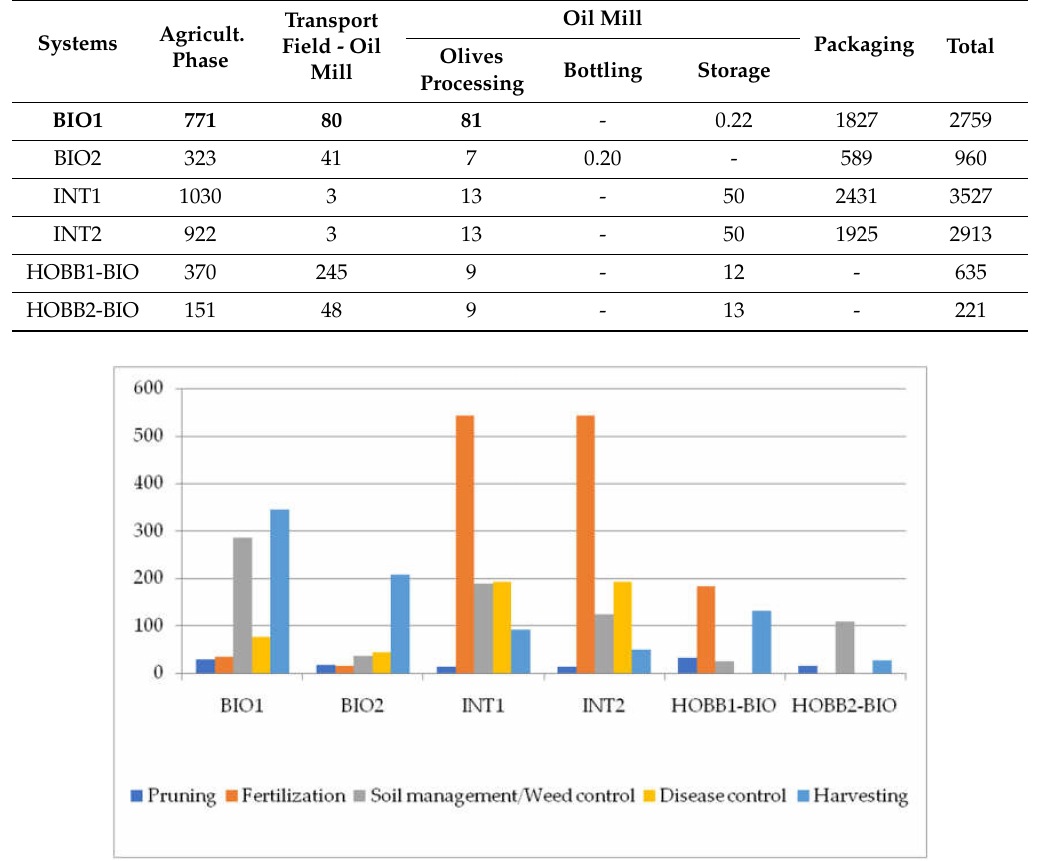
Figure 3. Agricultural phase: global warming (kg CO 2 eq ha –1 ) for the di ff erent agricultural